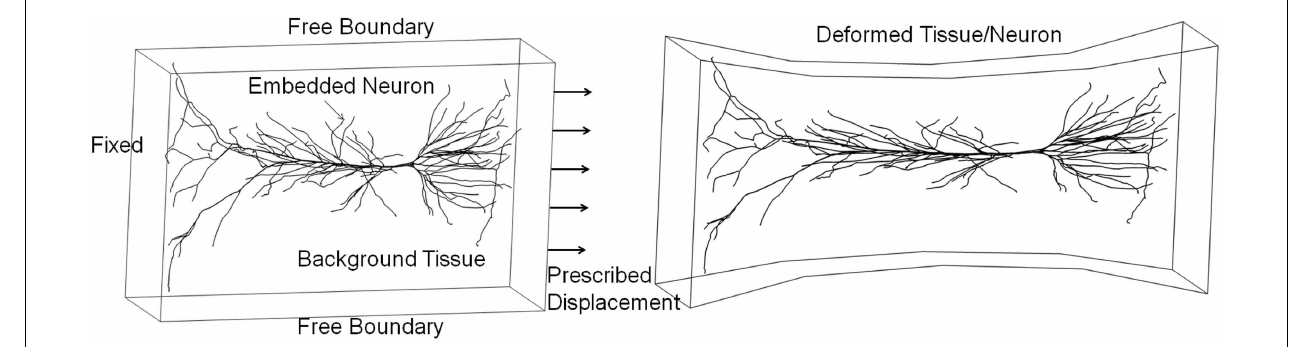
FIGURE 11 | Integrated biomechanical, electrokinetic, and metabolic model of an in vitro neuron exposed to mechanical stretching .